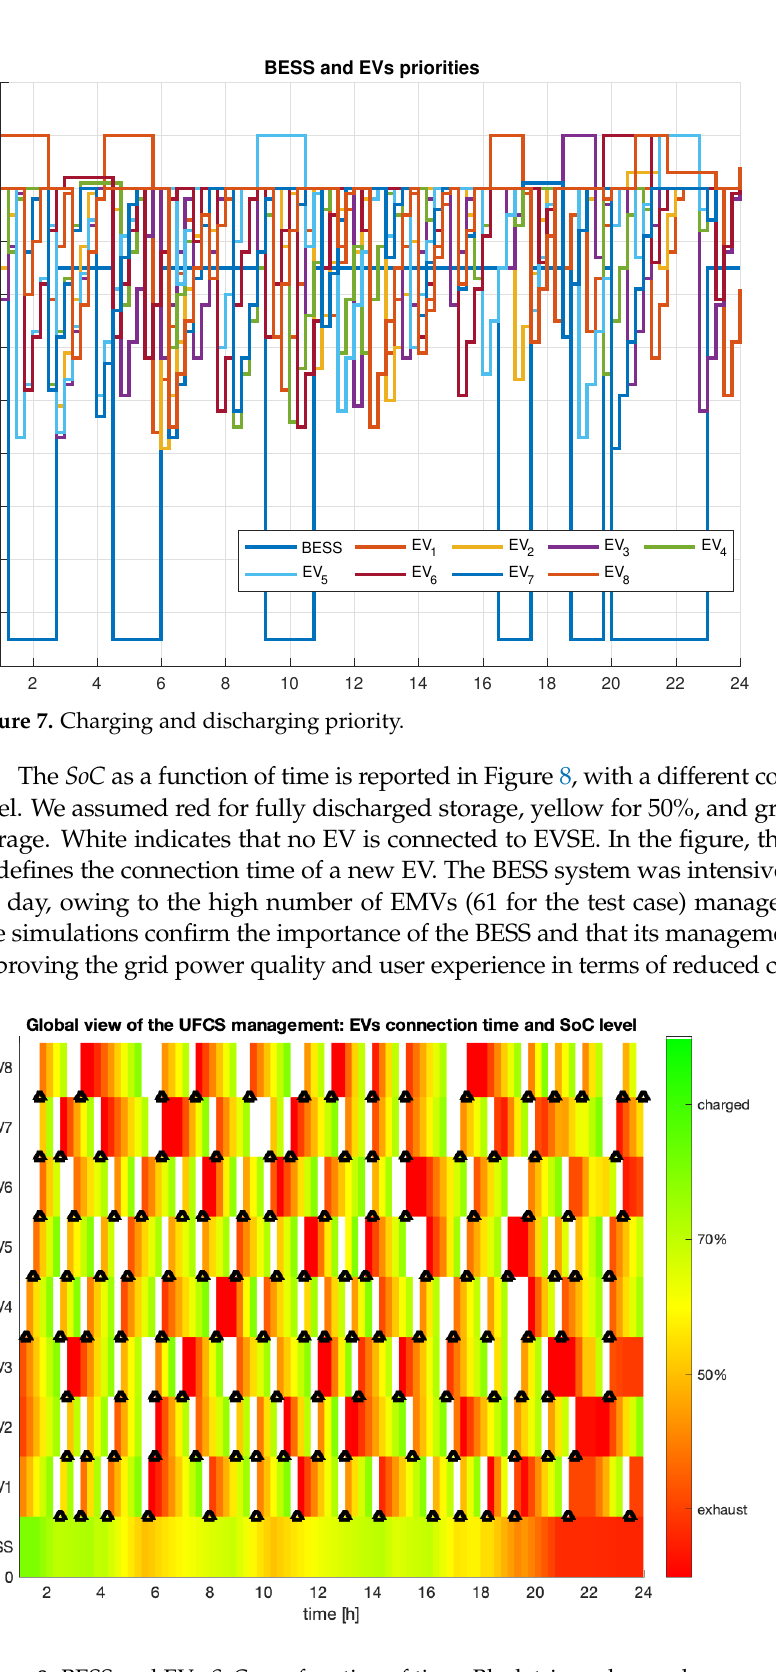
Figure 8. BESS and EVs SoC as a function of time. Black triangular markers are used to define the connection